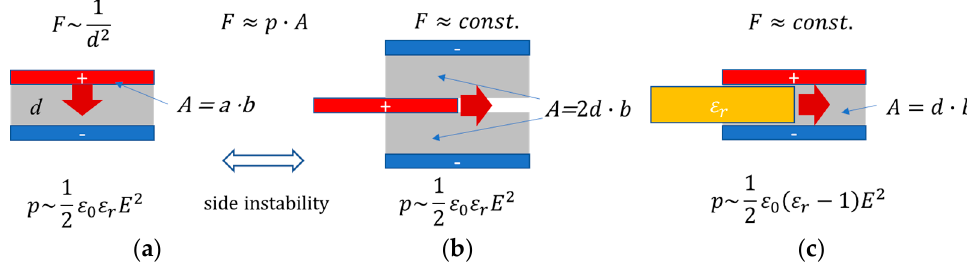
Figure 1. Overview of electrostatic actuators with tangential and vertical attracting forces. The electrostatic pressure and the relevant areas A for integration are given, respectively.